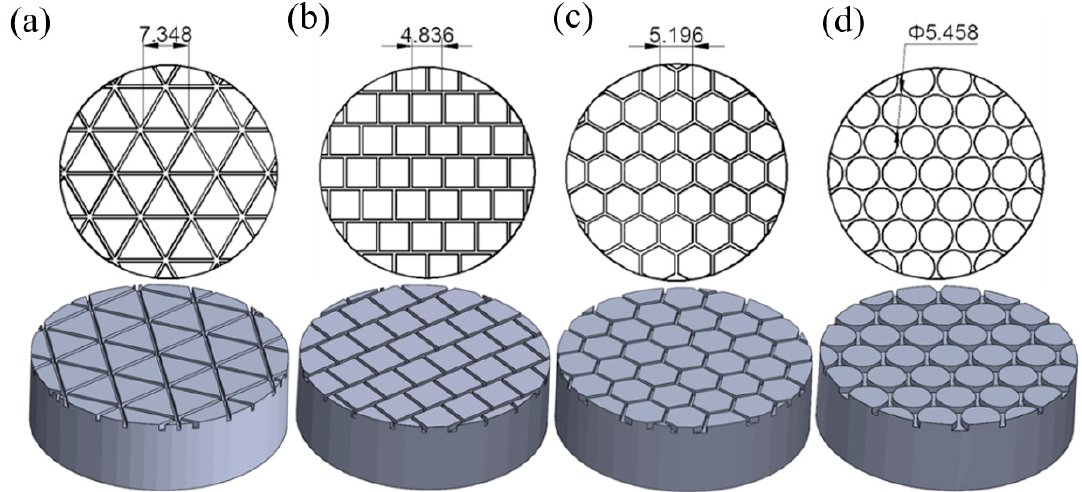
Figure 1. The schematic diagram of the specimens with four types of cross-grooved texture shapes: ( a ) triangle-textured specimen; ( b ) square-textured specimen; ( c ) hexagon-textured specimen; and ( d ) round-textured